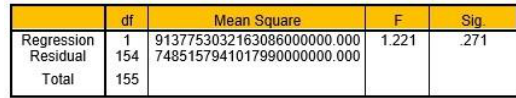
Table 6: Logarithmic Model Fitting Test Table